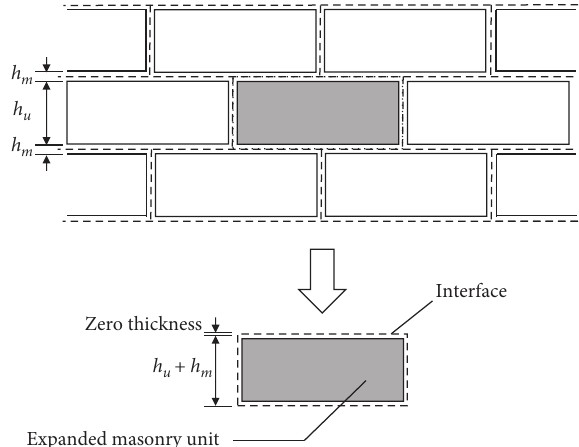
Figure 1: Discrete modeling